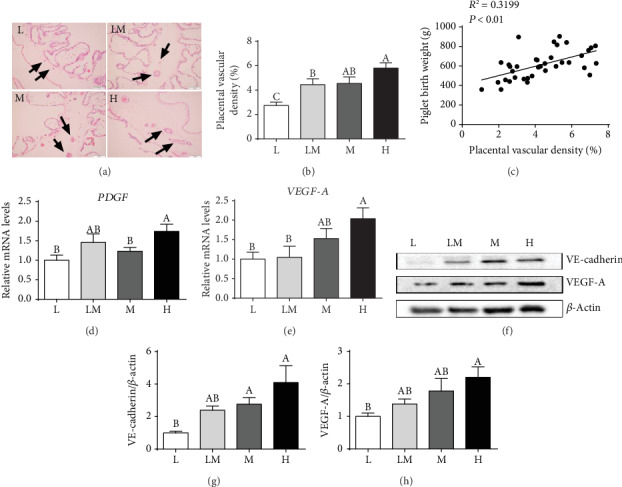
The vessel density distribution in the placentae. The hematoxylin & eosin method (a) was used to examine blood vessel density in placental tissues, and the black arrows indicate placental blood vessels (bar = 100 μm). (b) The percentage of blood vessels in the placental tissues. The numbers of replicates in the L, LM, M, and H groups were 10, 10, 9, and 9, respectively. Correlation between placental blood vessel density and piglet birth weight (c). mRNA levels of PDGF (d) and VEGF-A (e); n = 8 per group. Western blotting (f) and protein expression levels of VE-cadherin (g) and VEGF-A (h). Data are presented as mean ± SEM, and the numbers of replicates in the L, LM, M, and H groups were 10, 10, 9, and 9, respectively. Different letters indicate significant differences at P < 0.05.